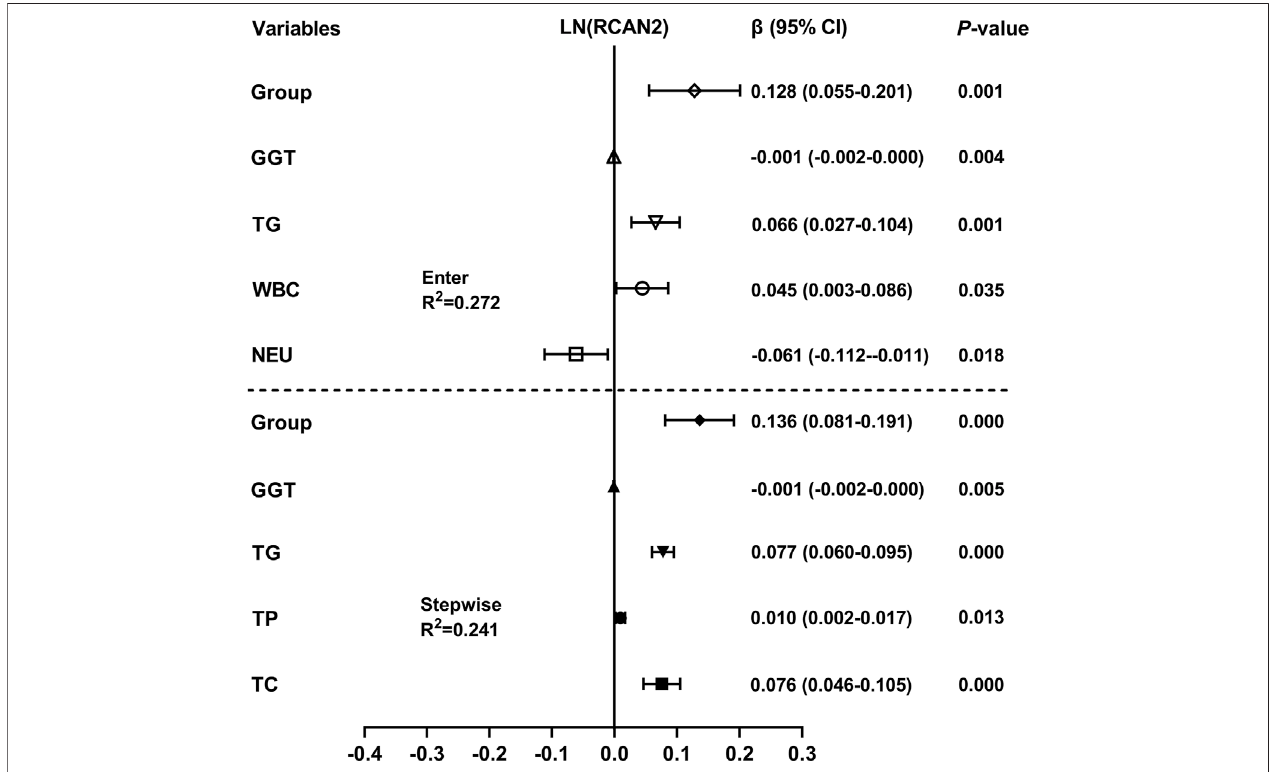
FIGURE3| Multiplelinearregressionanalysisofvariablesindependentlyassociatedwithserum RCAN2levelsinallparticipants. Theregressioncoef fi cients( β )and 95% con fi dence interval (CI) were displayed. Serum RCAN2 levels were naturally logarithmic transformed before analysis. The group of statistic: 1 = non-NAFLD, 2 = NAFLD.